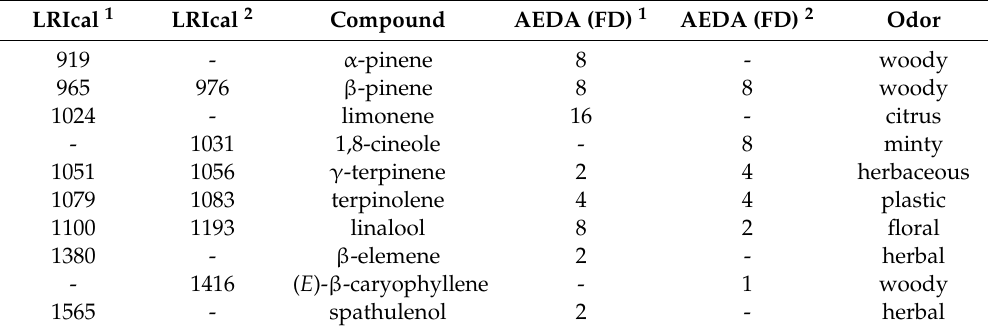
Table 5. Active-olfactory compounds of the essential oils from M. myrsinoides and M. mollis .